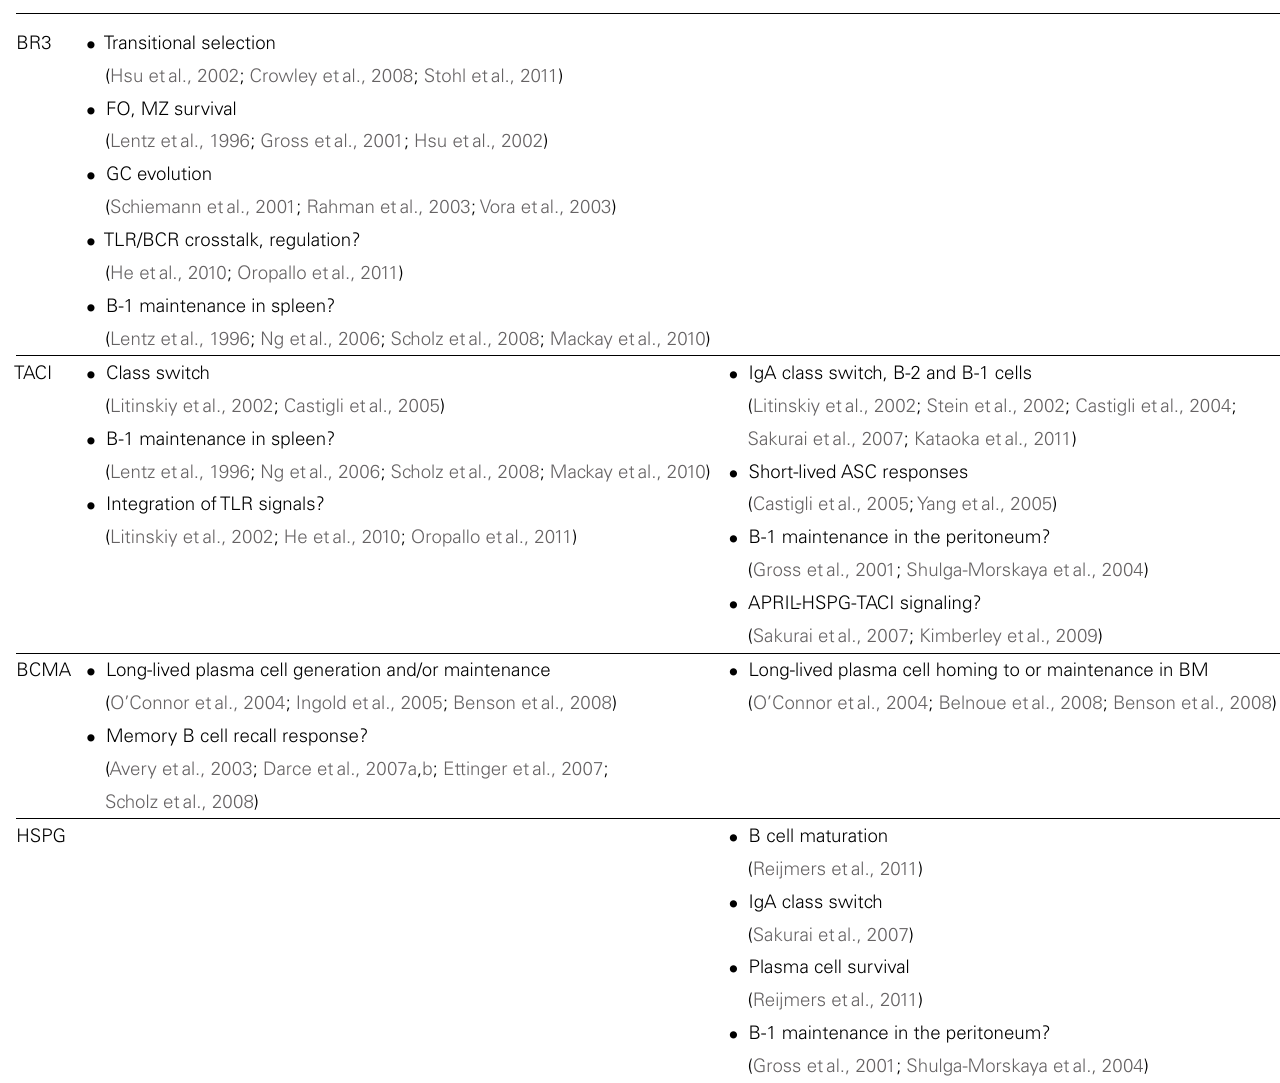
Table 1 | Roles for cytokine-receptor signals in murine B cell homeostasis. BLyS APRIL